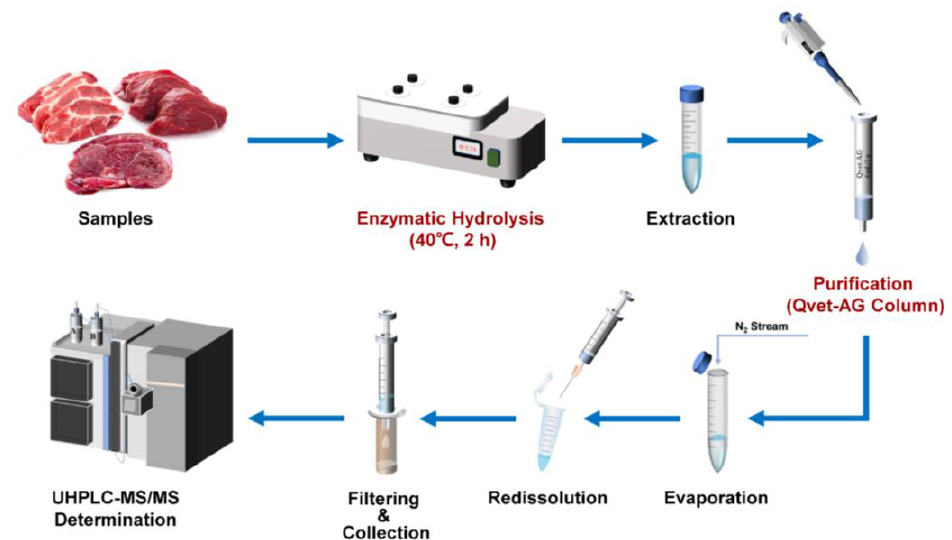
Figure 1. The schematic diagram of main experimental operation for the detection of β -agonists by UHPLC-MS/MS.